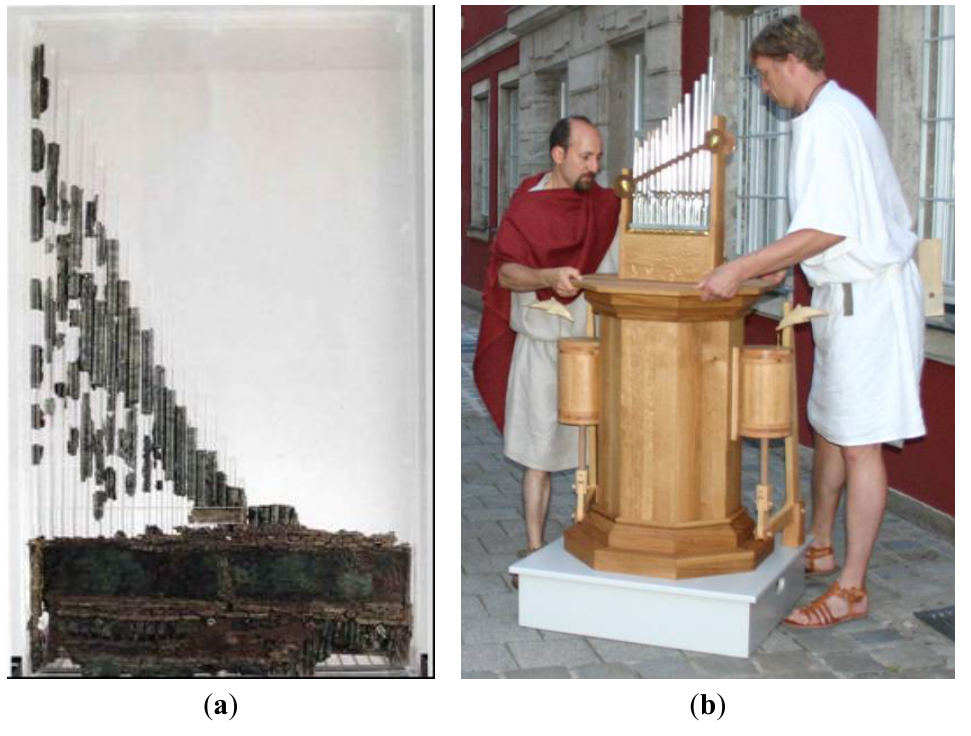
Figure 12. The Ktesivius’ Hydraulis—Fragmentary hydraulics with 19 bronze tubes from the 1st century BC: ( a ) from Museum at Dion in north Hellas (adapted from [54]); and ( b ) reconstruction of hydraulic organ at Weissenburg in Bayern (adapted from